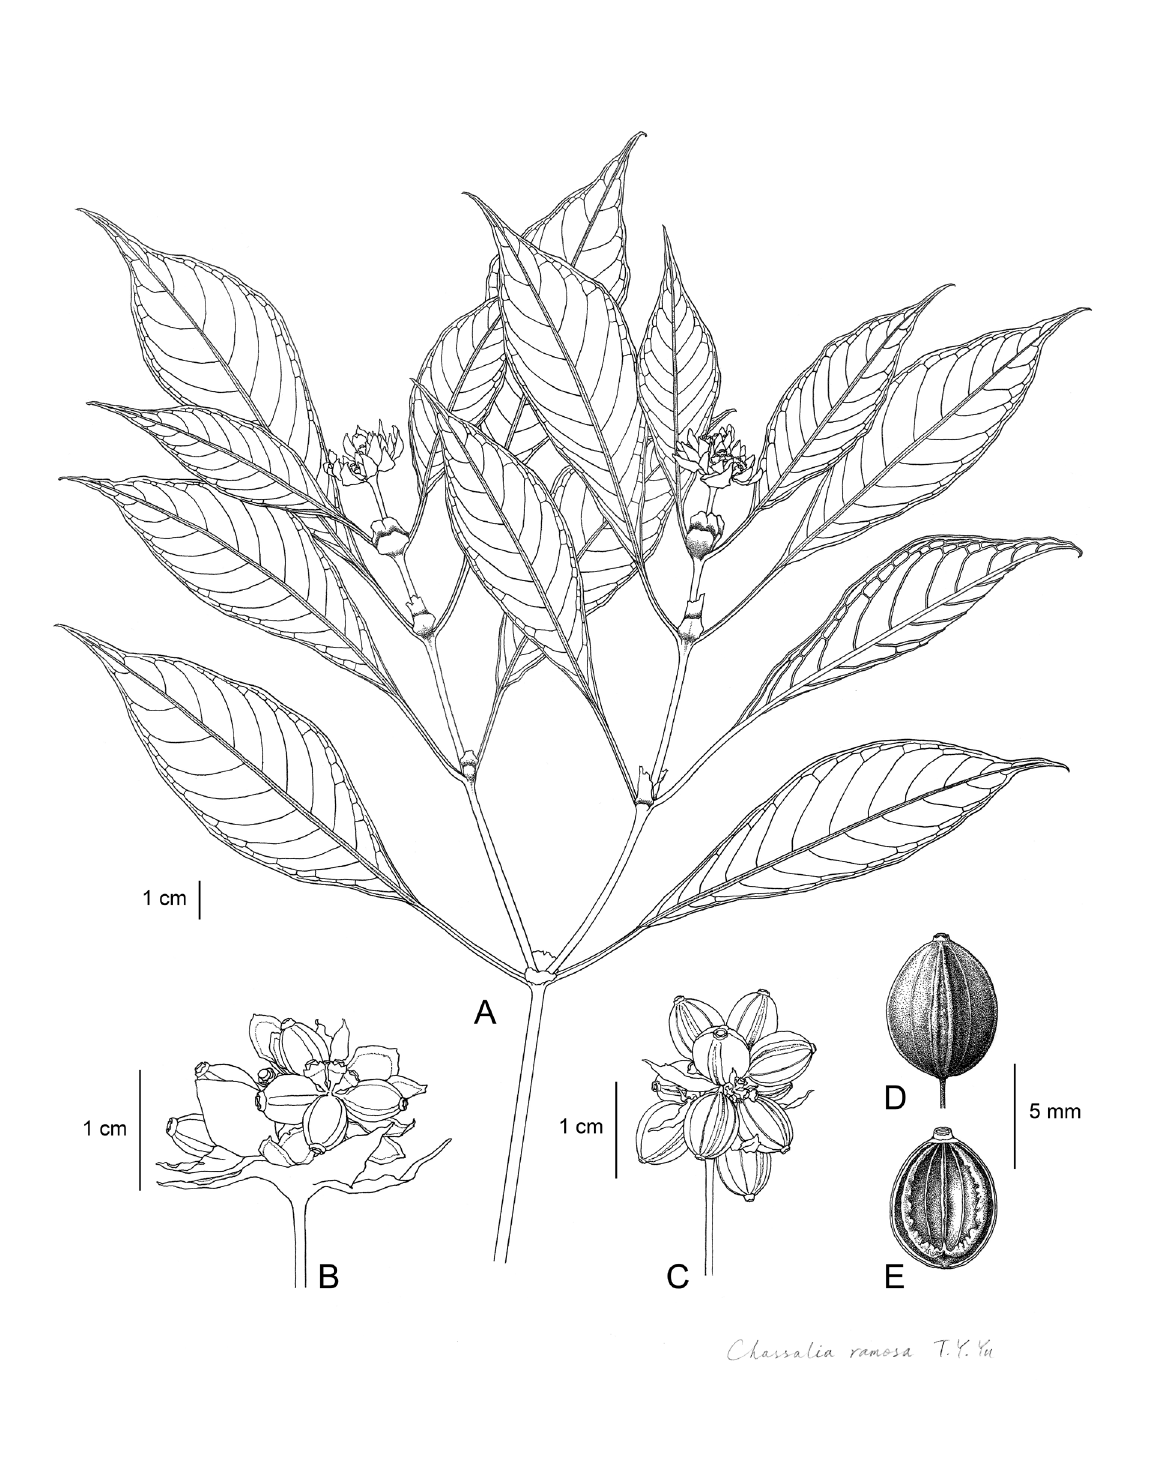
Fig. 30. Chassalia ramosa T.Y.Yu sp. nov. A . Flowering shoot. B . Infructescence with young fruit. C . Infructescence with ripe fruit. D . Dry fruit. E . Pyrene ventral surface. A–B from John H. Beaman 11533 ; C–E from John H. Beaman 11400 . Drawn by T.Y.